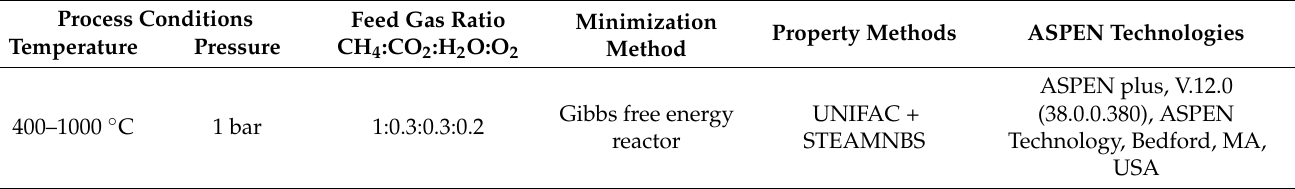
Figure 3. Thermodynamic equilibrium conversions of feed gases and syngas ratio using ASPEN plus. Reaction conditions: Pressure: 1 bar, temperature: 400–1000 °C, molar ratio: CH 4 :CO 2 :H 2 O:O 2 = 1:0.3:0.3:0.2. Table 1. Simulation settings and conditions considered for Figure 3.